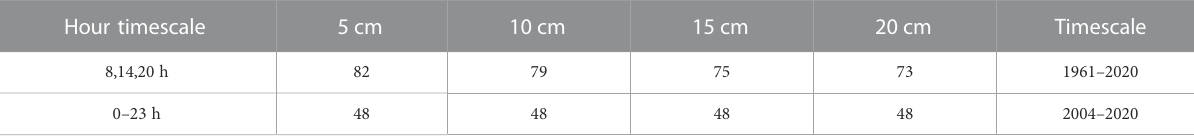
TABLE 1 Numbers of stations and timescales of the time series data of different soil layers used in this study. Hour timescale 5 cm 10